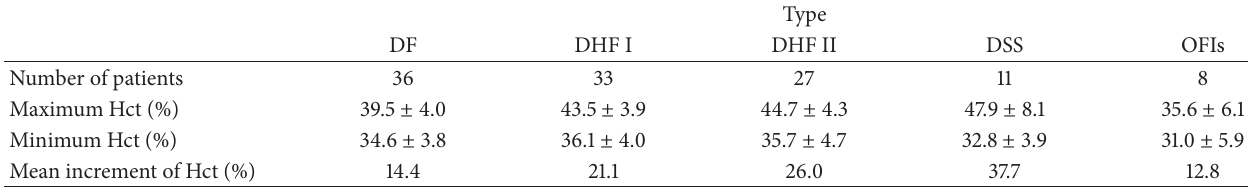
Table 3: Mean of maximum, minimum, and percentage of increment of Hct in patients with DF, DHF grades I and II, DSS, and OFIs.